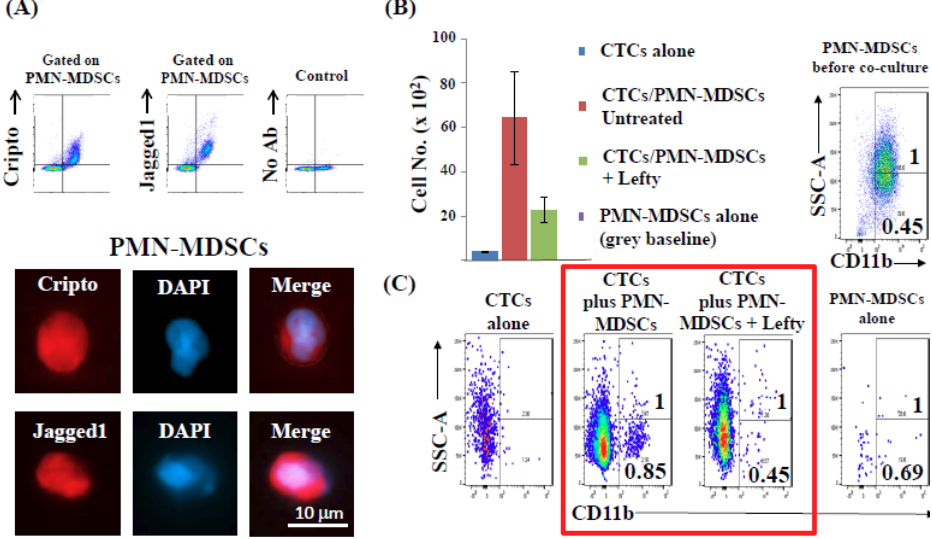
Figure 9. ( A ) Detection of Cripto/Jagged1 over-expression in PMN-MDSCs isolated from blood of BCBM patients by FACS followed by high-definition immunofluorescence (IF) microscopy. Single-cell images of a representative experiment ( n = 4) are shown. ( B ) Co-cultures of CTCs with PMN-MDSCs isolated from BCBM patients not treated (red), or treated with Nodal inhibitor Lefty (green). CTCs (blue) or PMN-MDSCs cultured alone (grey, at baseline) represent negative controls. Data are mean ± SD of four independent experiments ( n = 4). ( C ) Red frame shows PMN-MDSC transdi ff erentiation / phenotypic changes induced following co-culture with CTCs isolated from the same patient; however, changes were abrogated by incubation with Nodal inhibitor Lefty (1 µ g / mL for 96 h at 37 ◦ C) [34]. Ratios between CD11b +/ SSC-A and CD11b +/ SSC-A low are shown in a representative experiment ( n =